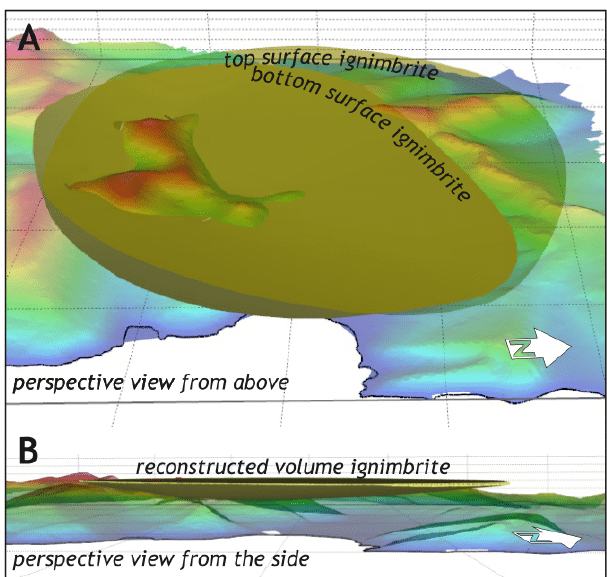
Figure 14: [A] Perspective view and [B] side view of the three-dimensional reconstruction of the Breiðuvík caldera-infill (Hvítserkur) ignimbrite from mapping of the bottom and top surface of the ignimbrite. The re- construction and volume calculation were done in Move 2018 (Petroleum Experts). The caldera bottom is bowl- shaped (see also Cross section C–C (cid:48) in Figure 13). Note that the caldera depression was not entirely filled by the ignimbrite. A caldera lake formed after the eruption, as evident from lacustrine sediments and basaltic hyalo- clastites erupted in the